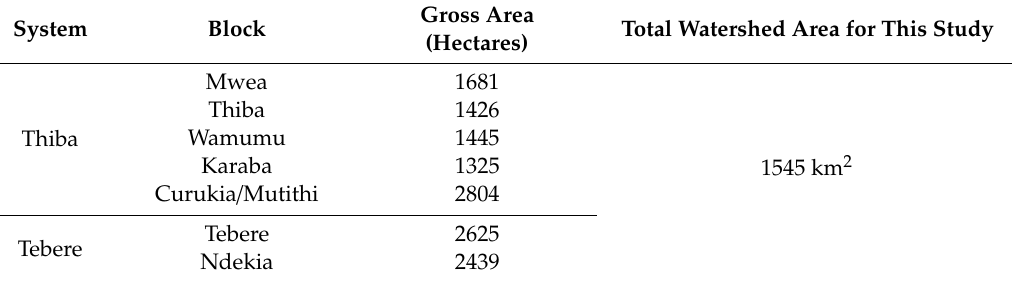
Table 1. Summary of Thiba and Tebere systems, blocks and watershed area.